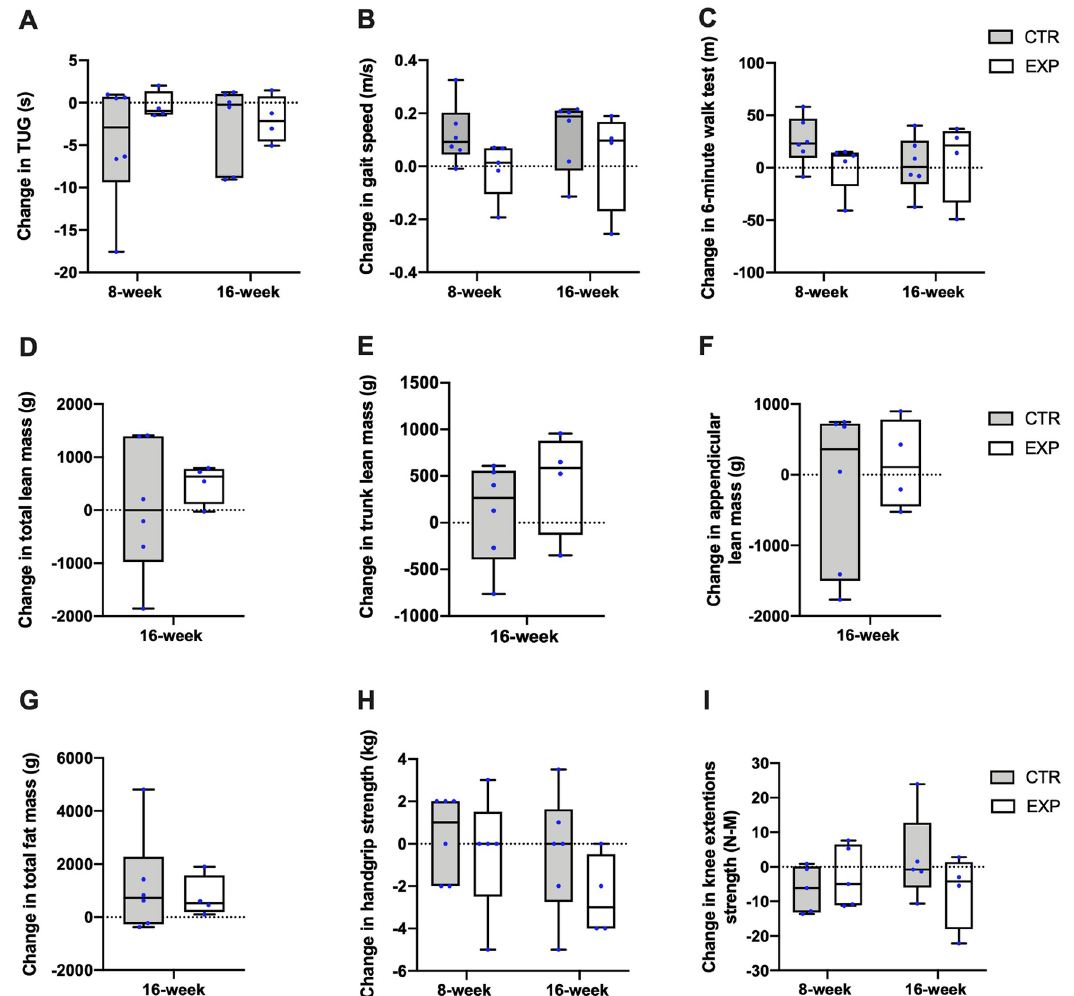
Fig 3. Boxplots showing changes between baseline and week 8, and week 16 in (A) Timed up and go (TUG), (B) gait speed, (C) 6-minute walk test, (D) total lean mass, (E) trunk lean mass, (F) appendicular lean mass, (G) total fat mass, (H) handgrip and (I) knee extension strength by group. Boxes are interquartile ranges and horizontal lines inside boxes are medians. Whiskers represent the minimal and maximal value and the blue dots represent the participants’ individual value. The dotted lines indicate a change of